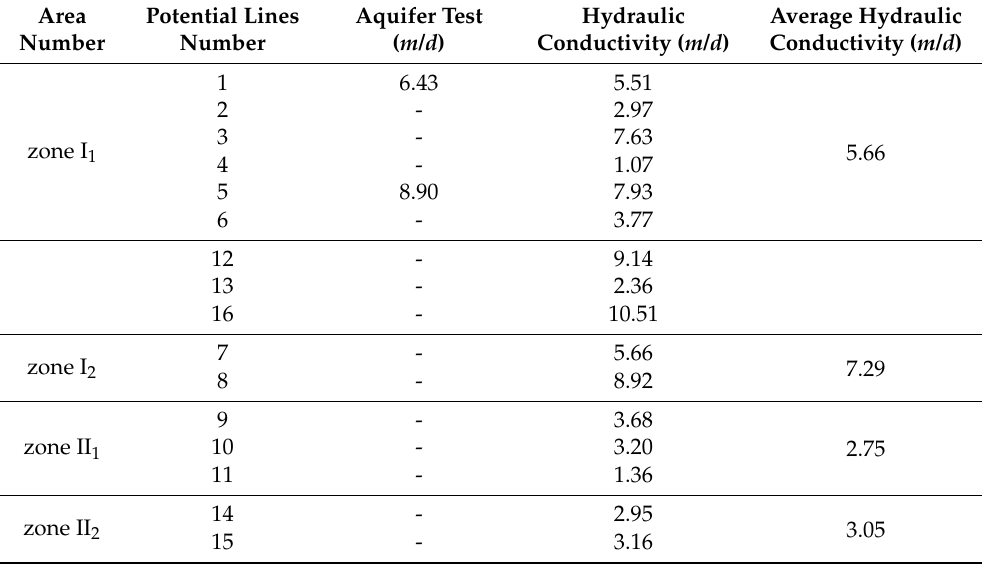
Table 2. Hydraulic conductivity calculated at each sampling point in the study area.